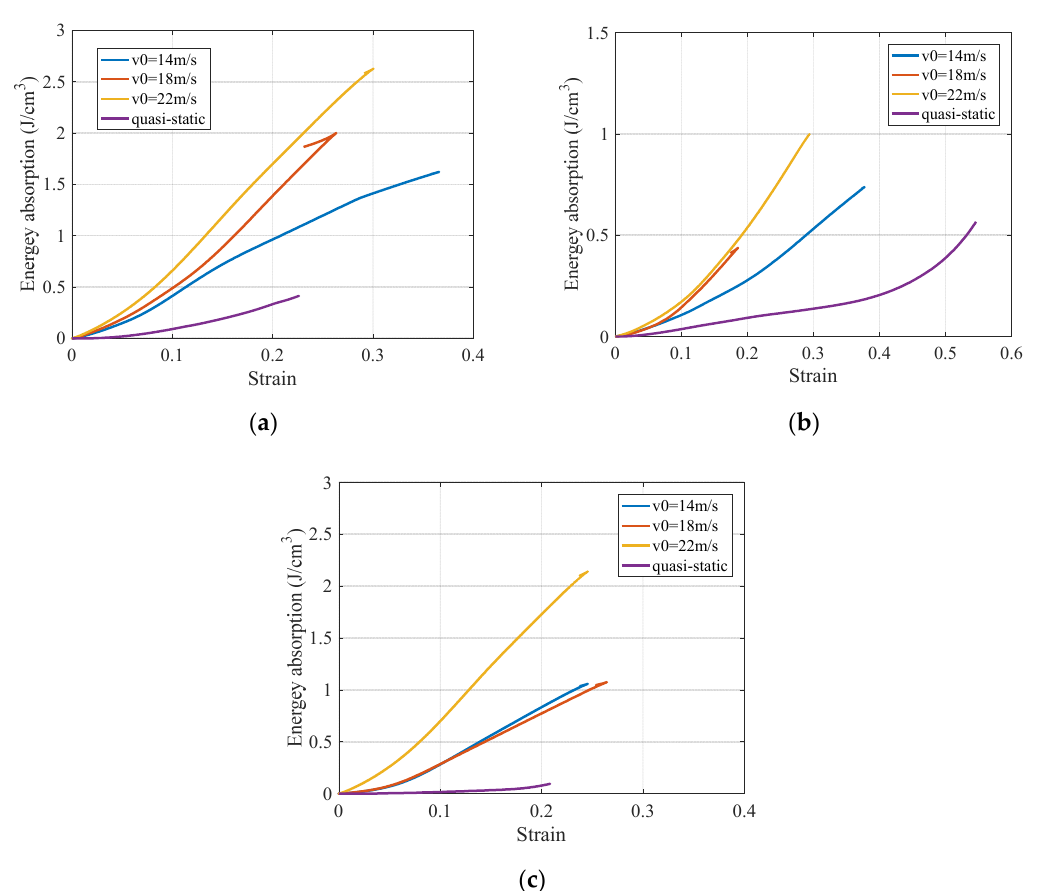
Figure 9. Comparison of the energy absorption of specimens under different impact velocities and quasi-static tests. ( a ) C2, ( b ) C3, ( c ) C5. Table 3. Comparison of the energy absorption (J/cm 3 ) of the specimens under SHPB tests and quasi-static compression tests.